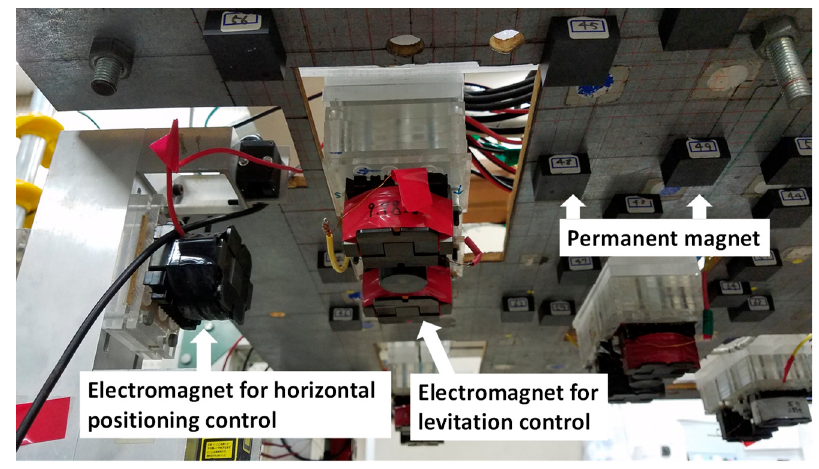
Figure 2. Photograph of the placement of permanent magnets around the levitation electromagnets.